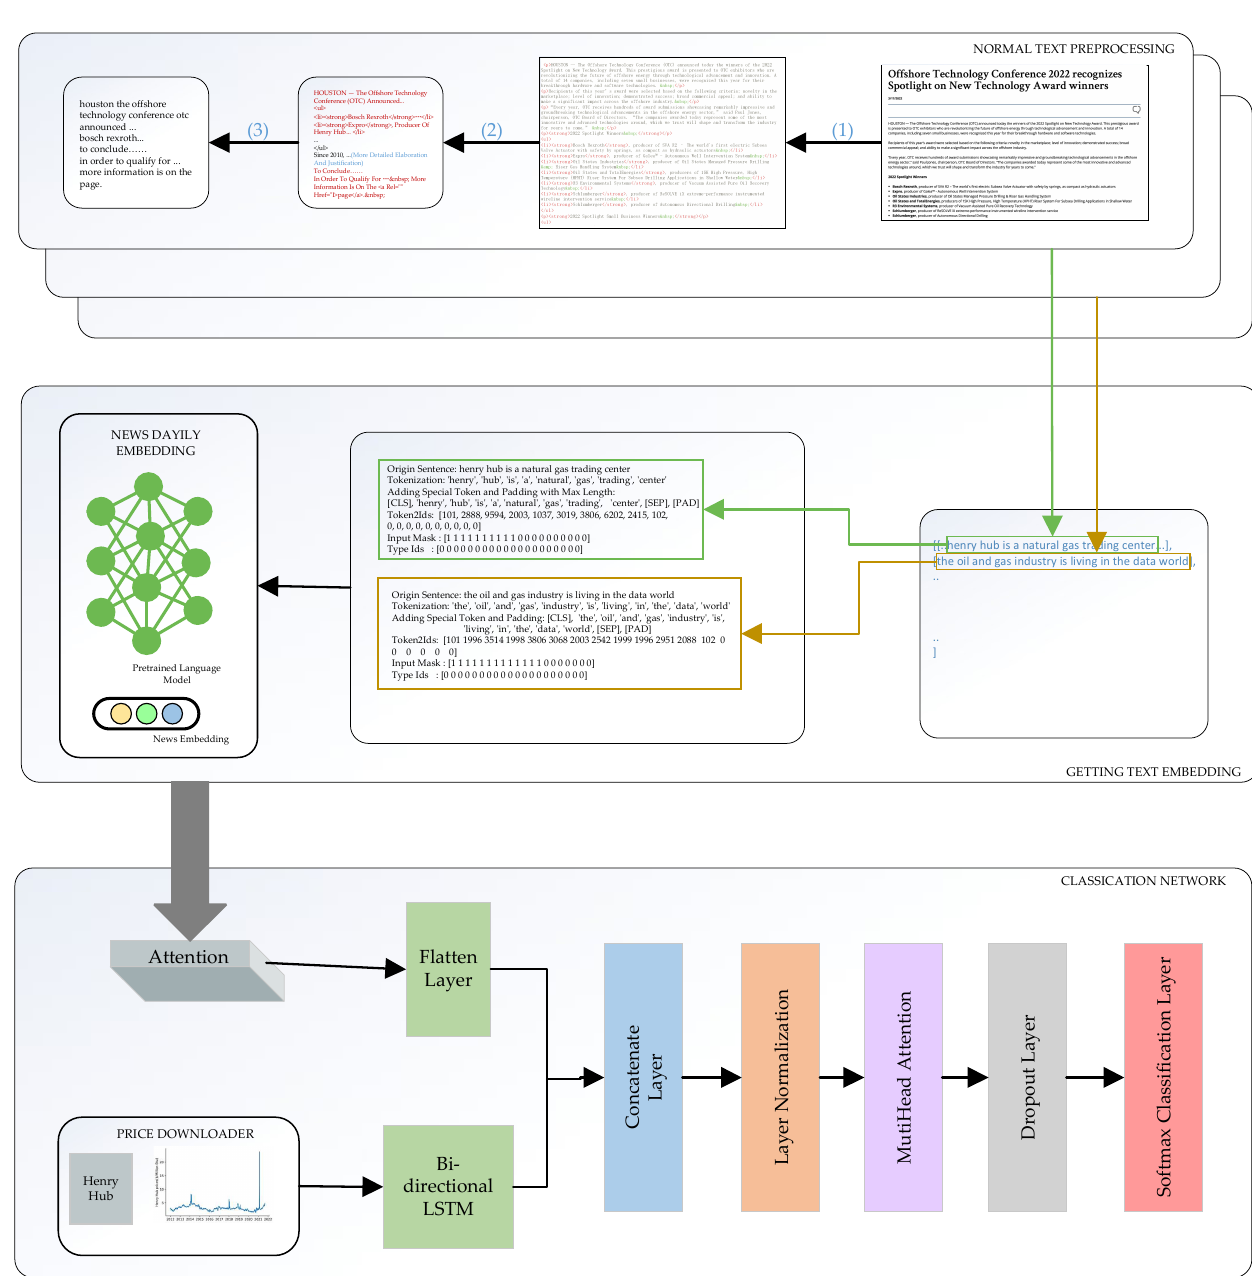
Figure 1. An overall pipeline of our work. There are three steps to standardize the text. Step (1) is to display the codes behind the web pages. Step (2) is to parse information through a spider. Useless information is removed in Step (3), including releasing redundant HTML tags, lowercasing all letters, removing the punctuation marks, intercepting part of text, etc. The details are described in Section